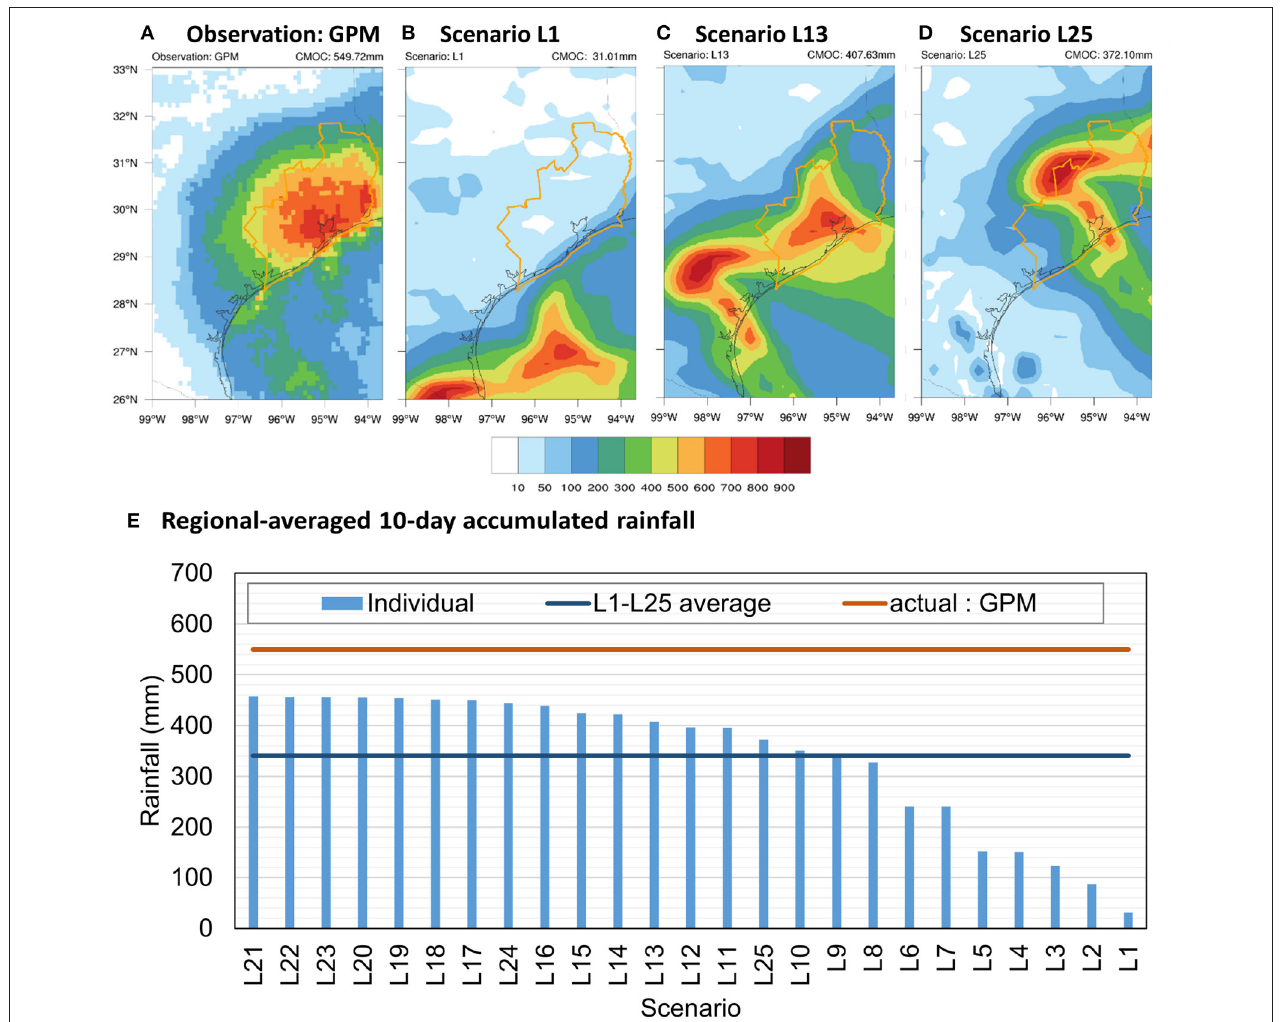
FIGURE 7 | Comparison of 10-day accumulated rainfall in the CMOC region between 25 scenarios (model) and GPM (observation). (A) Spatial pattern of GPM, (B) results from scenario L1, (C) results from L13, (D) results from L25, (E) CMOC regional-averaged rainfall from scenarios using weather predictions and from satellite-based observations from GPM from August 24 to September 2,